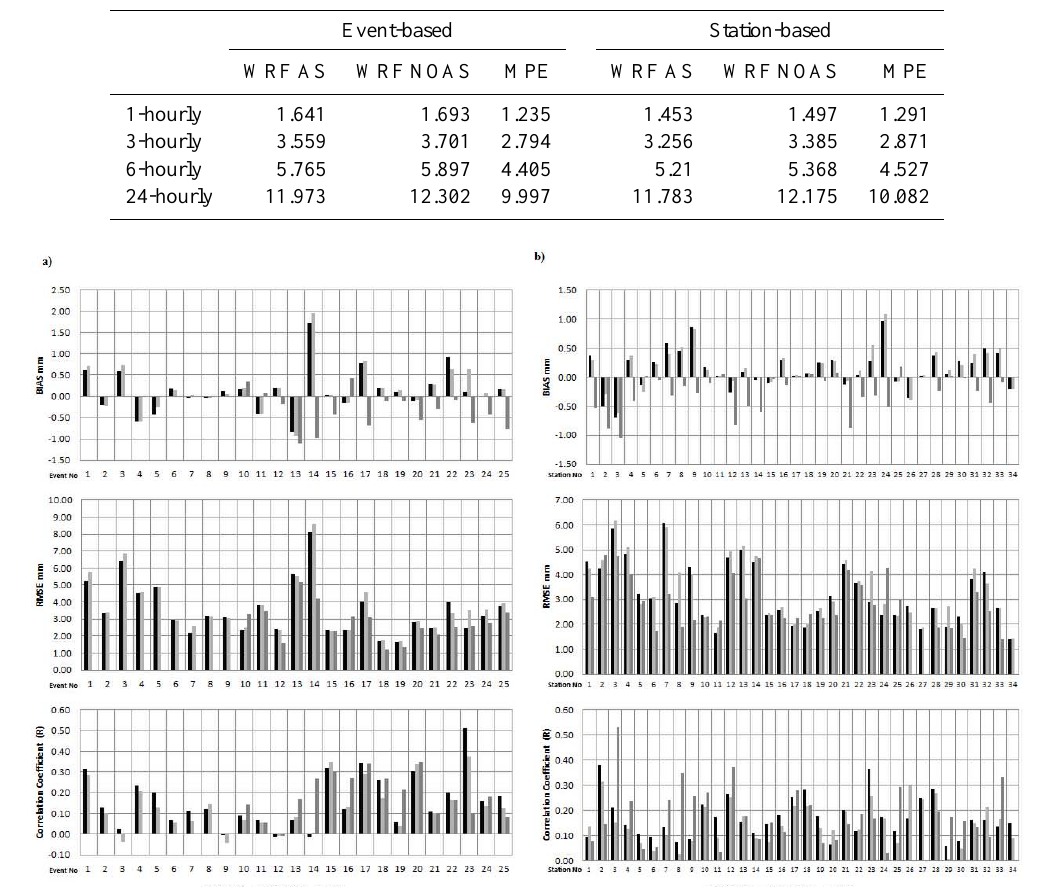
Table 5. Mean RMSE in [mm] values of WRF AS, WRF NOAS and MPE at 1, 3, 6, and 24h intervals are given for event- and station-based analyses.